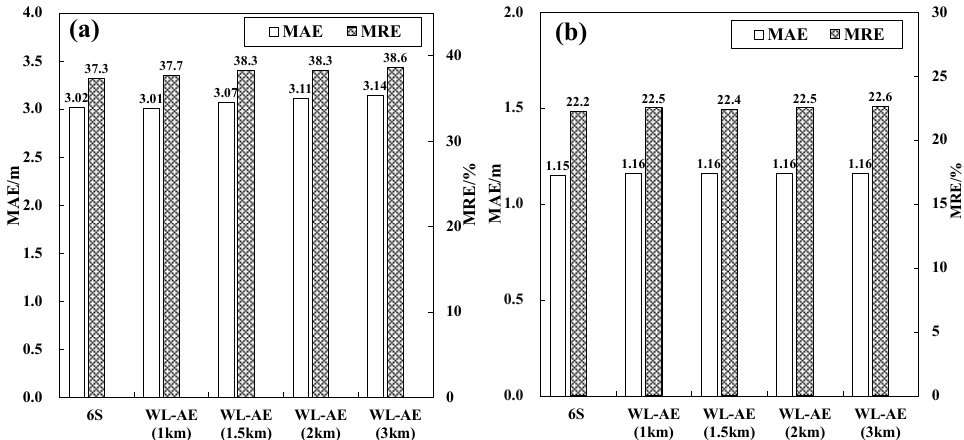
Figure 7. Accuracy diagram of the bathymetric inversion results in the range of 20 m under the 6S and WL-AE correction results. ( a ) Penang; ( b ) Socotra.